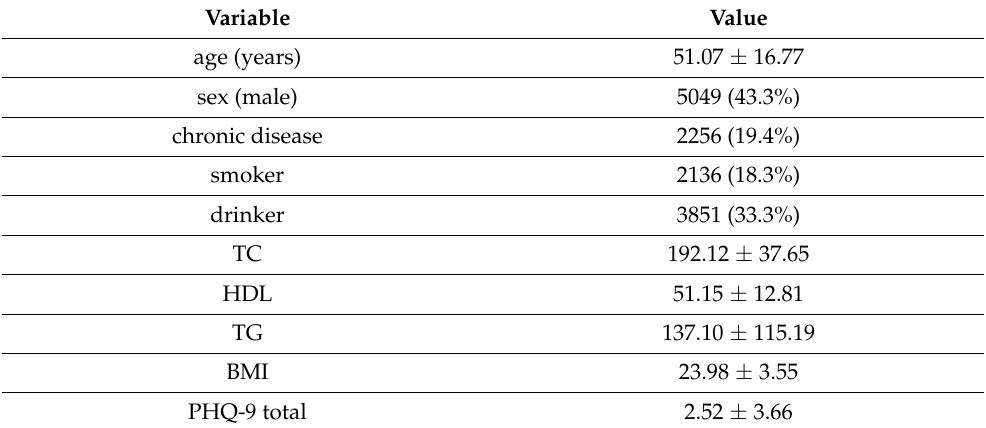
Table 1. General characteristics of the participants ( n = 11,653).